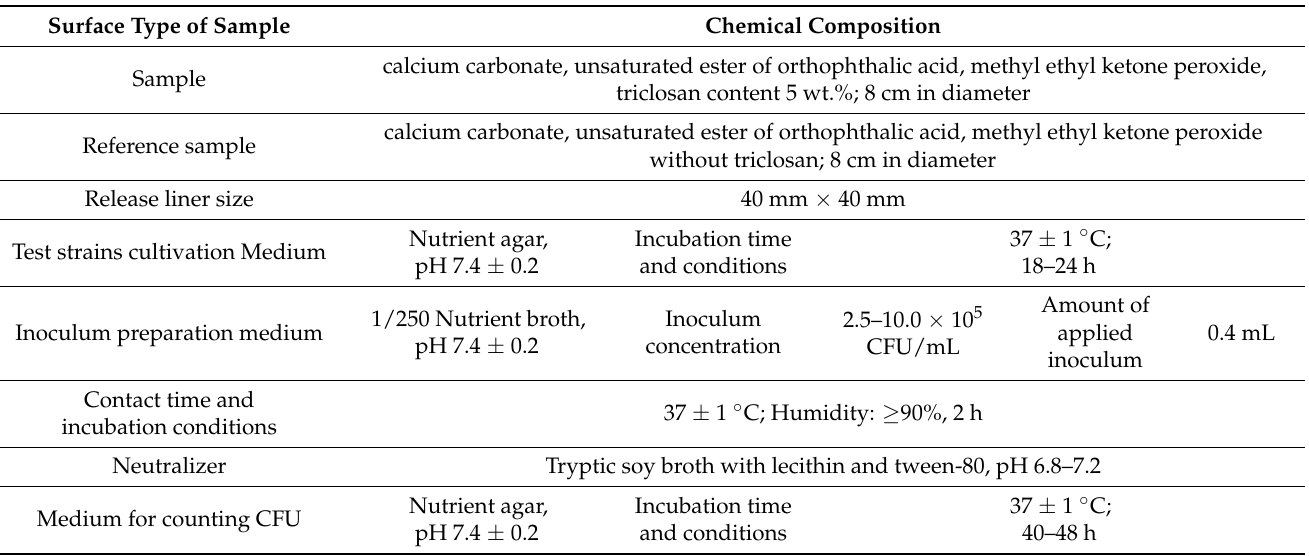
Table 3. The parameters used in the biological